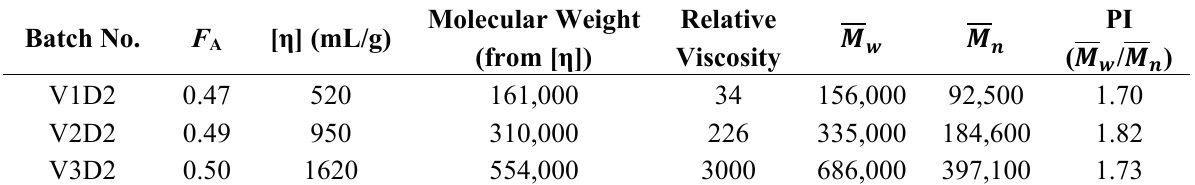
Table 1. Properties of the chitosan